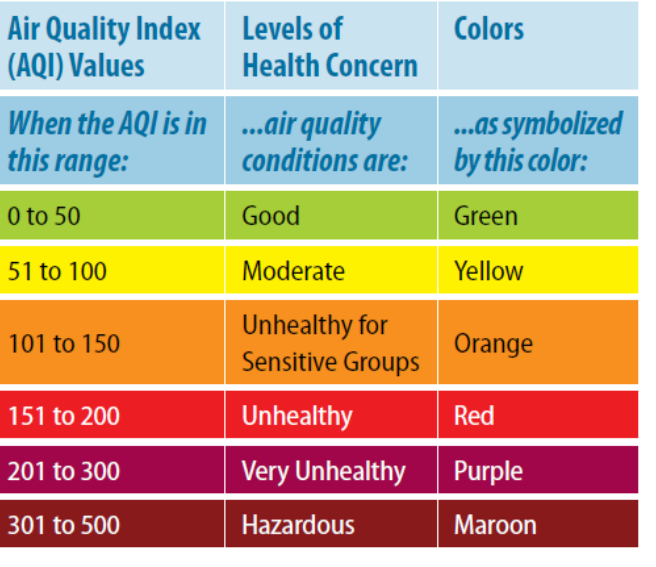
Figure 2. Air Quality Index guidelines